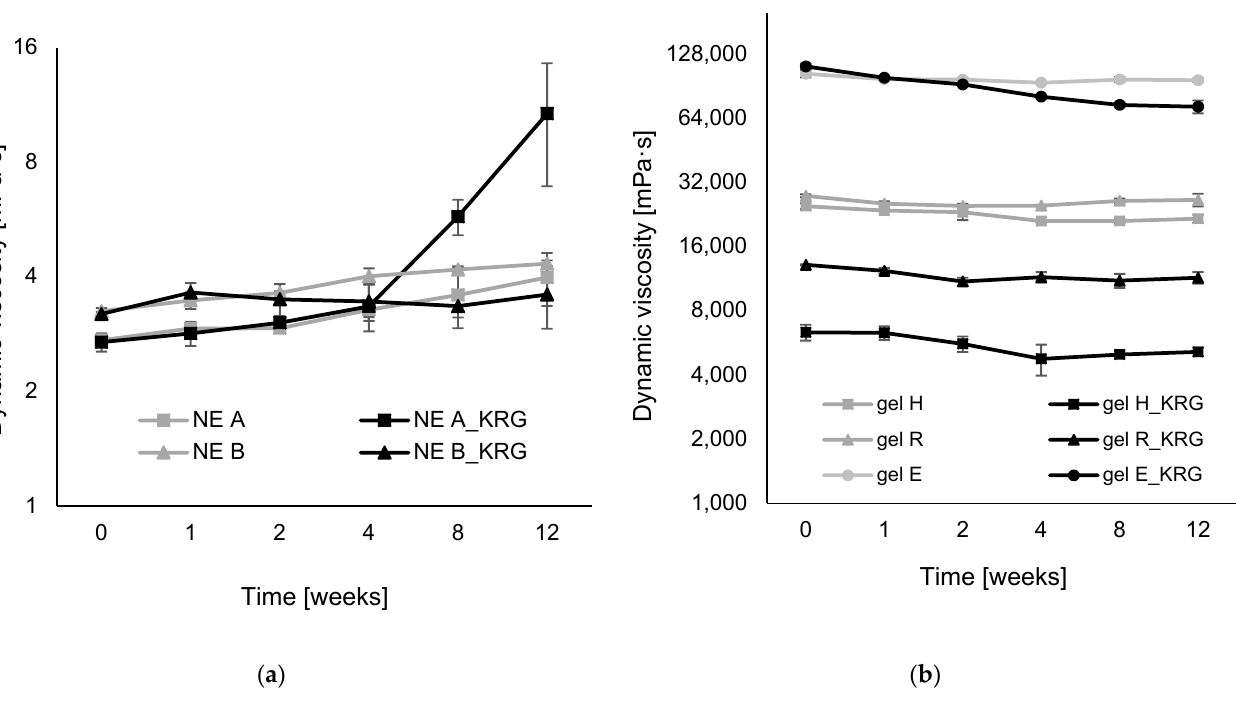
Figure 7. Dynamic viscosity, η , in mPas of ( a ) oil-in-water NEs and ( b ) hydrogels with and without KRG extract at a shear rate of 10 s − 1 (logarithmic scale). ( a ) Grey squares: NE A, black squares: NE A_KRG, grey triangles: NE B, black triangles: NE B_KRG. ( b ) Grey squares: gel H, black squares: gel H_KRG, grey triangles: gel R, black triangles: gel R_KRG, grey circles: gel E, black circles: gel E_KRG. Values are means ± SD of n = 3 formulations analysed at room temperature (23 °C). All NEs exhibited linear flow behaviour during the entire measurement period, as visualised in the flow curves in Figure 6a. The corresponding viscosity curves (supple- mentary Figure S1a) confirm this observation, although some viscosity fluctuations at very low shear rates were frequently observed. The initial dynamic viscosity was higher for NE B than NE A (NE A: 2.73 ± 0.06, NE B: 3.25 ± 0.06 at 10 s − 1 , p < 0.001). The same was